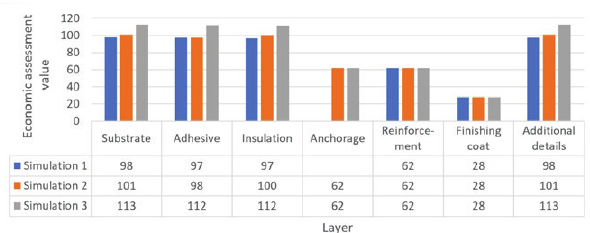
Figure 7. The average occurrence and detectability value of the degradation factors by the sequence of the construction